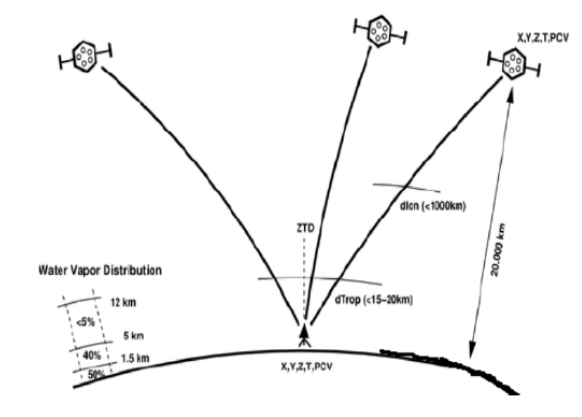
Figure 1: Water vapour distribution and atmospheric layers in re- lation to GNSS satellites. X ; Y ; Z are coordinates of satellites and antenna positions, T is the epoch of observation, PCV are phase center values of transmitting and receiving antenna, ZTD is the zenith tropospheric